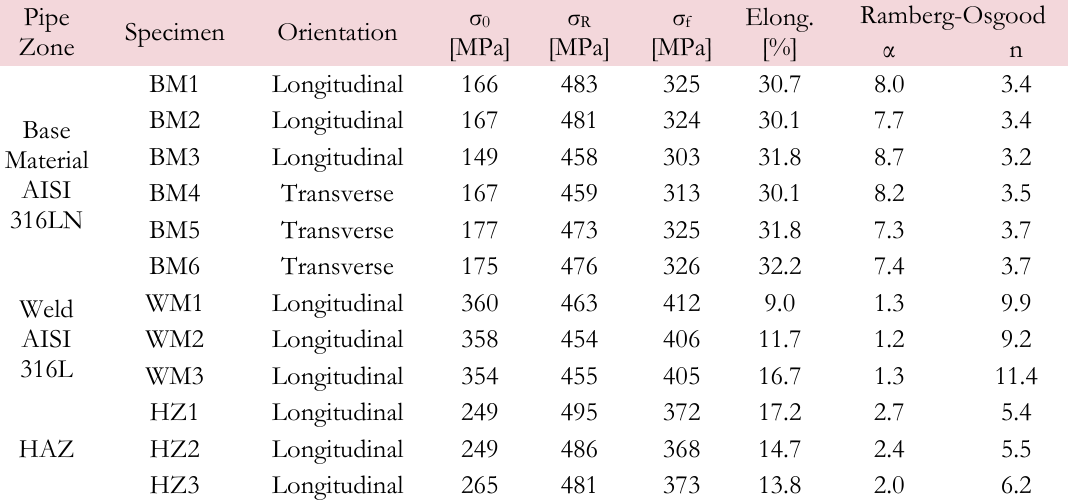
Table 2: Results of hot tensile tests.